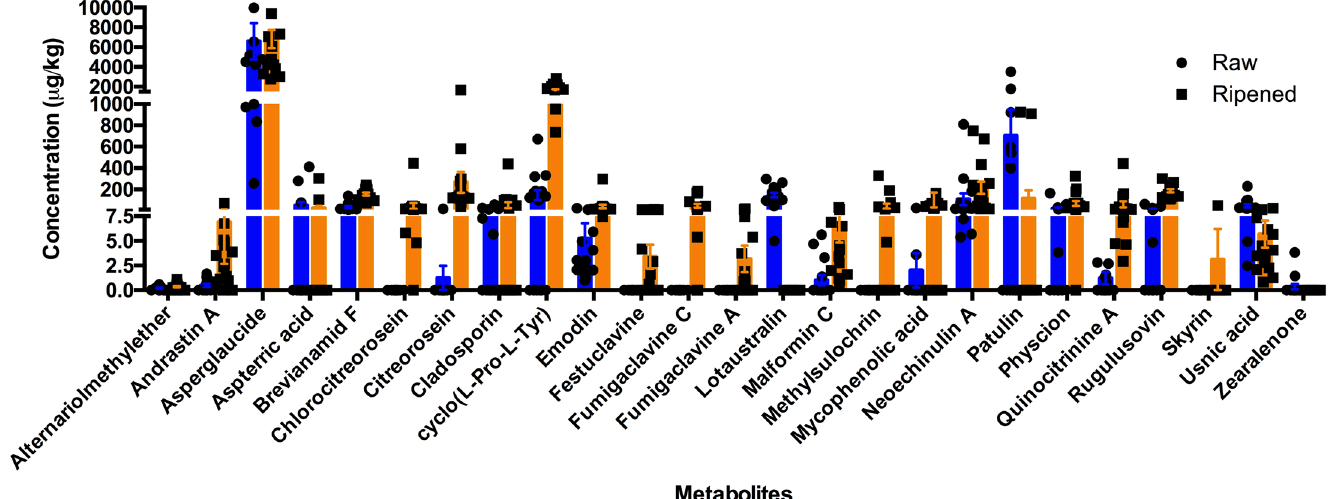
Fig 4. Detection of toxic metabolites in raw and ripened Pu-erh samples. Raw Pu-erh samples are indicated by circles, and ripened samples by squares. Mean concentrations and standard deviations of each metabolite in raw (in blue) and ripened (in orange) Pu-erh samples are